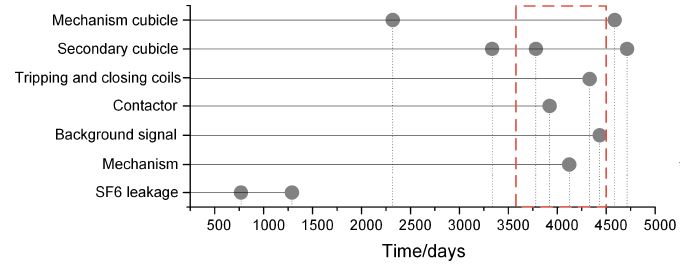
Figure 2. A graphical illustration of a failure sequence.